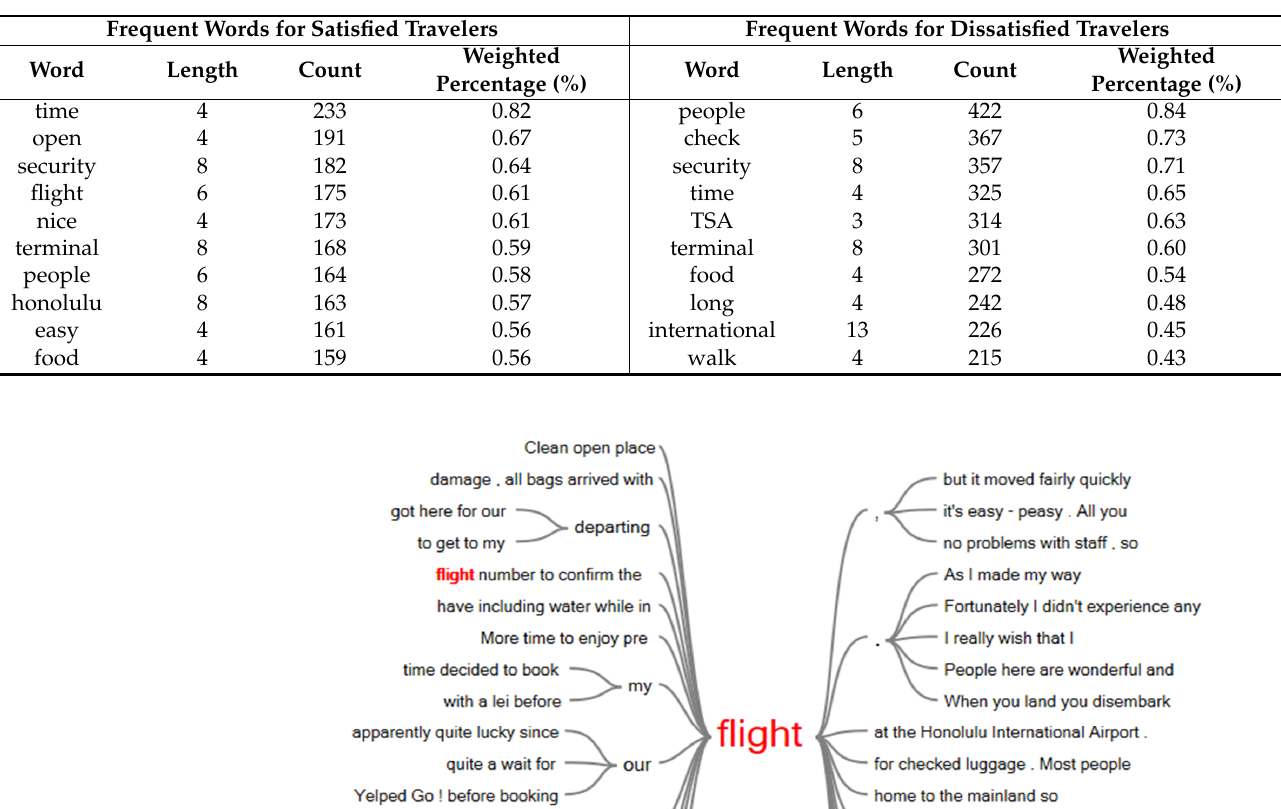
Table A1. Frequently Occurring Words for the Honolulu International Airport.